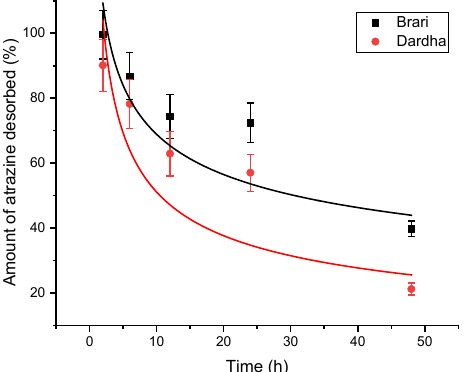
Figure 4. Desorbed amounts (%) of atrazine (25 mg/L) from Brari and Dardha clay. The curves show that atrazine desorbed faster from Brari clay than from Dardha clay. This was expected because, as shown above, Dardha clay better adsorbed atrazine, so consequently, its desorption would be slower. As can be seen from the curve, in the first two hours of clay-water solution of atrazine contact, 99.1% of atrazine was desorbed. The data in Figure 5 present the desorbed amounts of benalaxyl from natural Brari and Dardha clays. From the curves obtained, we can see that the desorption process of benalaxyl from Brari clay was faster than for Dardha clay. It is worth noting that the desorption process is generally faster than the adsorption process, where this process is slower.